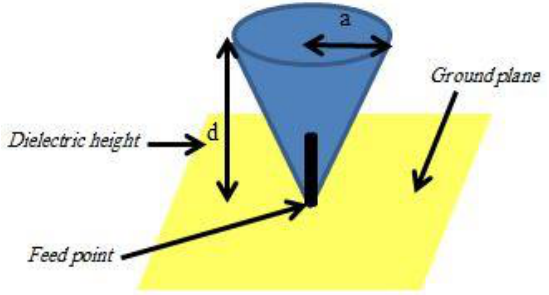
Figure 1: The geometry of cone-inverted DRA.